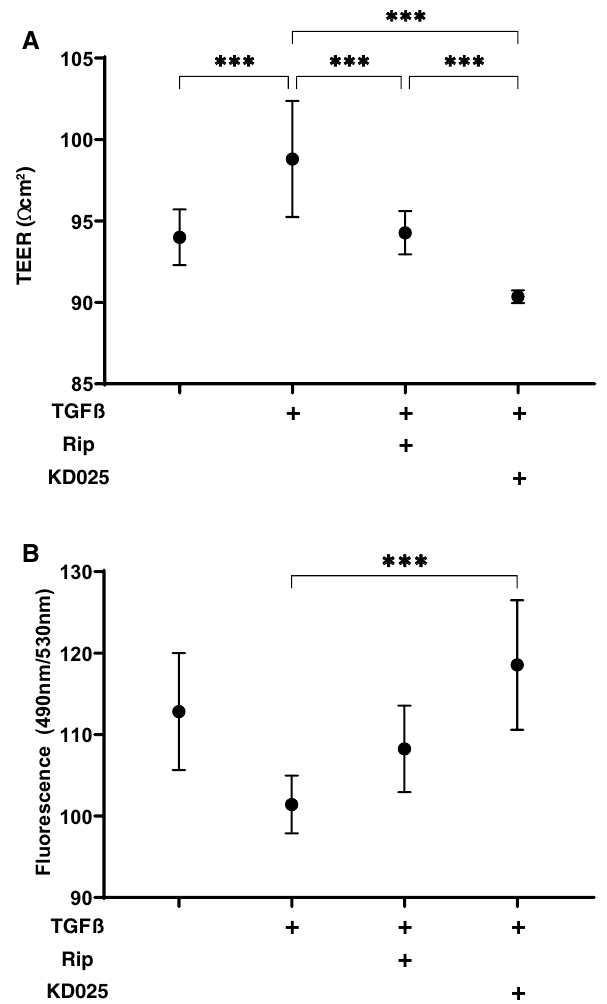
Figure 1. Effects of ROCK-is on transendothelial electrical resistance (TEER) ( A ) and FITC-dextran permeability ( B ) of TGFβ2 treated 2D culture of HTM cell monolayer. To evaluate the effects of 10 μM ripasudil (Rip) or KD025 on the barrier function (Ωcm 2 ) and the permeability of TGFβ2 untreated or treated 2D cultured HTM monolayers, TEER (panel A ) and FITC-dextran permeability (panel B ) measurements were performed, respectively. All experiments were performed in triplicate using fresh preparations (n = 4). Data are presented as the arithmetic mean ± standard error of the mean (SEM). *** P < 0.005 (ANOVA followed by a Tukey’s multiple comparison